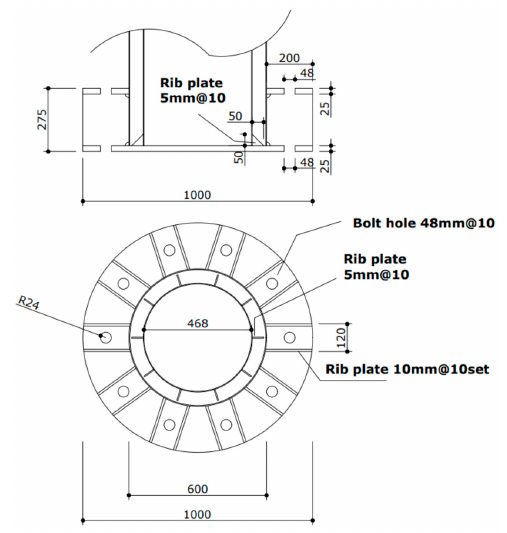
Figure 11. Base plate. Figure 11. Base